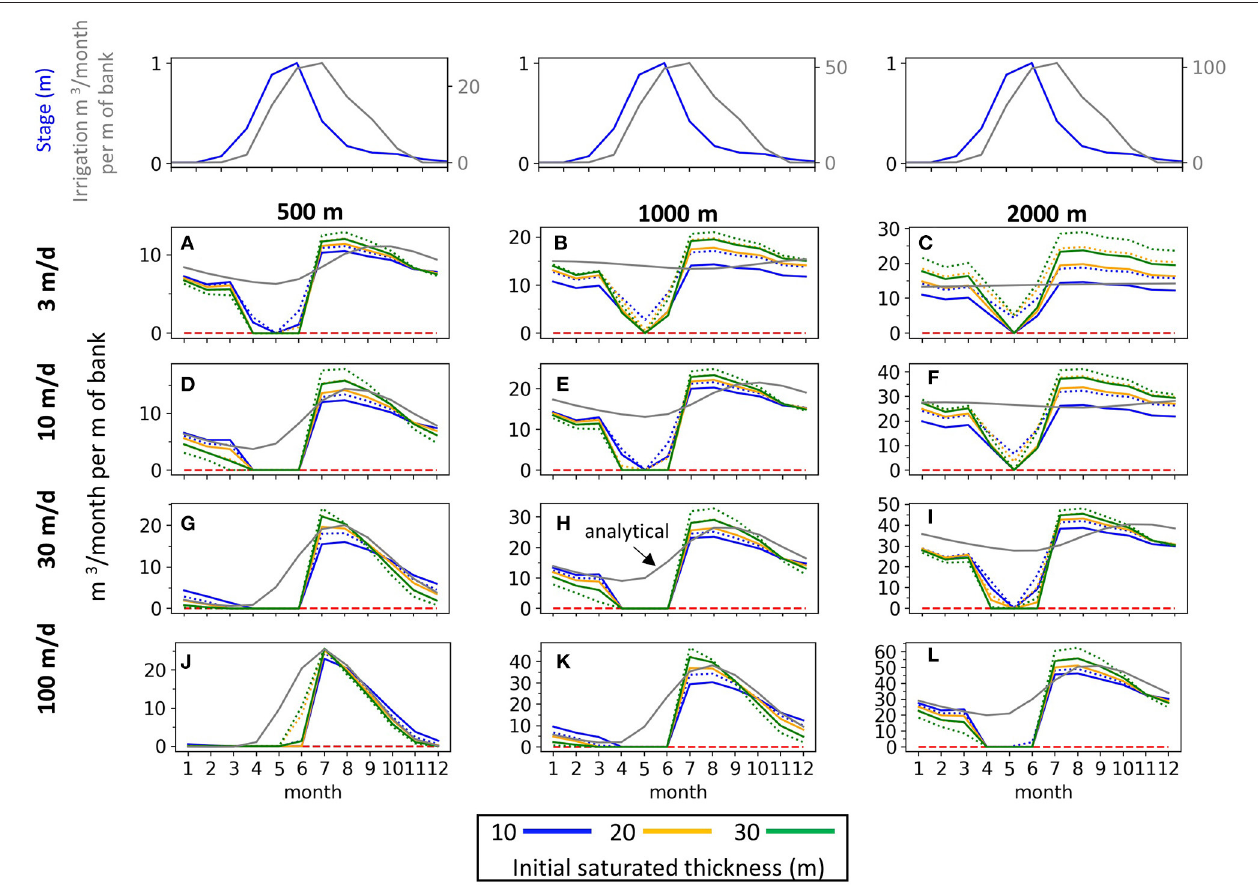
FIGURE 6 | Return flow results for Group 1. The six return flow curves within each combination of aquifer width (columns) and K (rows) correspond to three different initial aquifer saturated thicknesses (colors) and two specific yield values for each saturated thickness (dashed = Sy 0.2, solid = Sy 0.3). Stream stage and recharge boundary conditions are plotted above the return flow results to provide reference of how return flow timing relates to the boundary conditions. Gray line shows the analytical solution with an aquifer thickness of 20m and Sy =